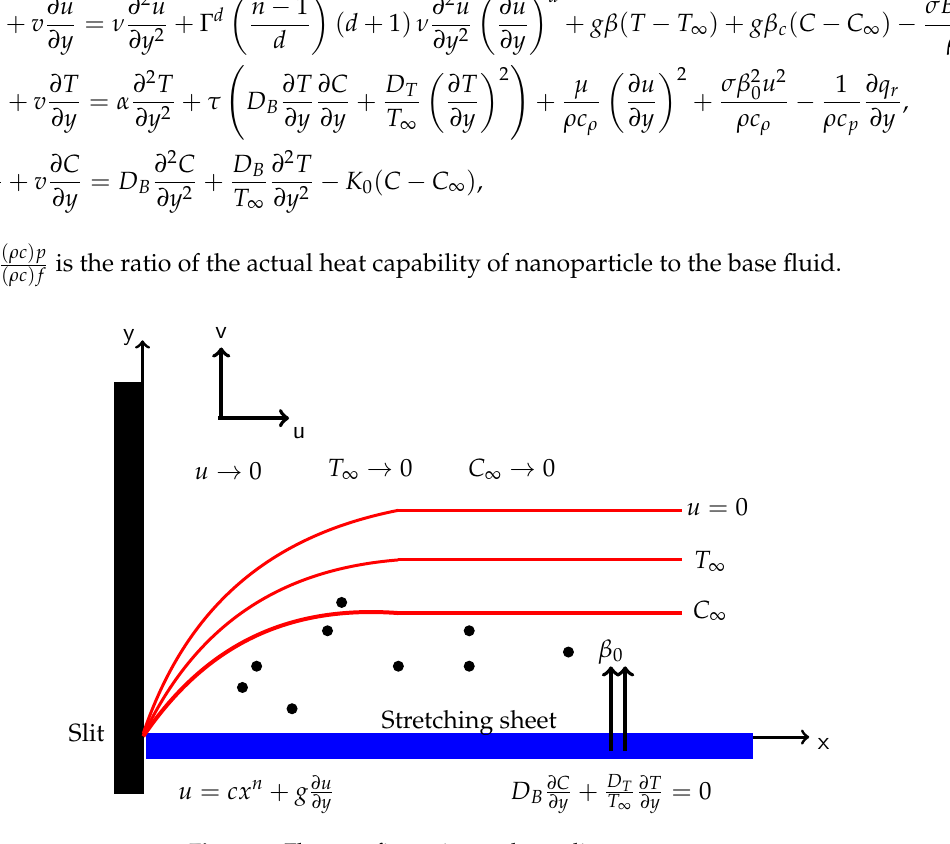
Figure 1. Flow configuration and coordinate